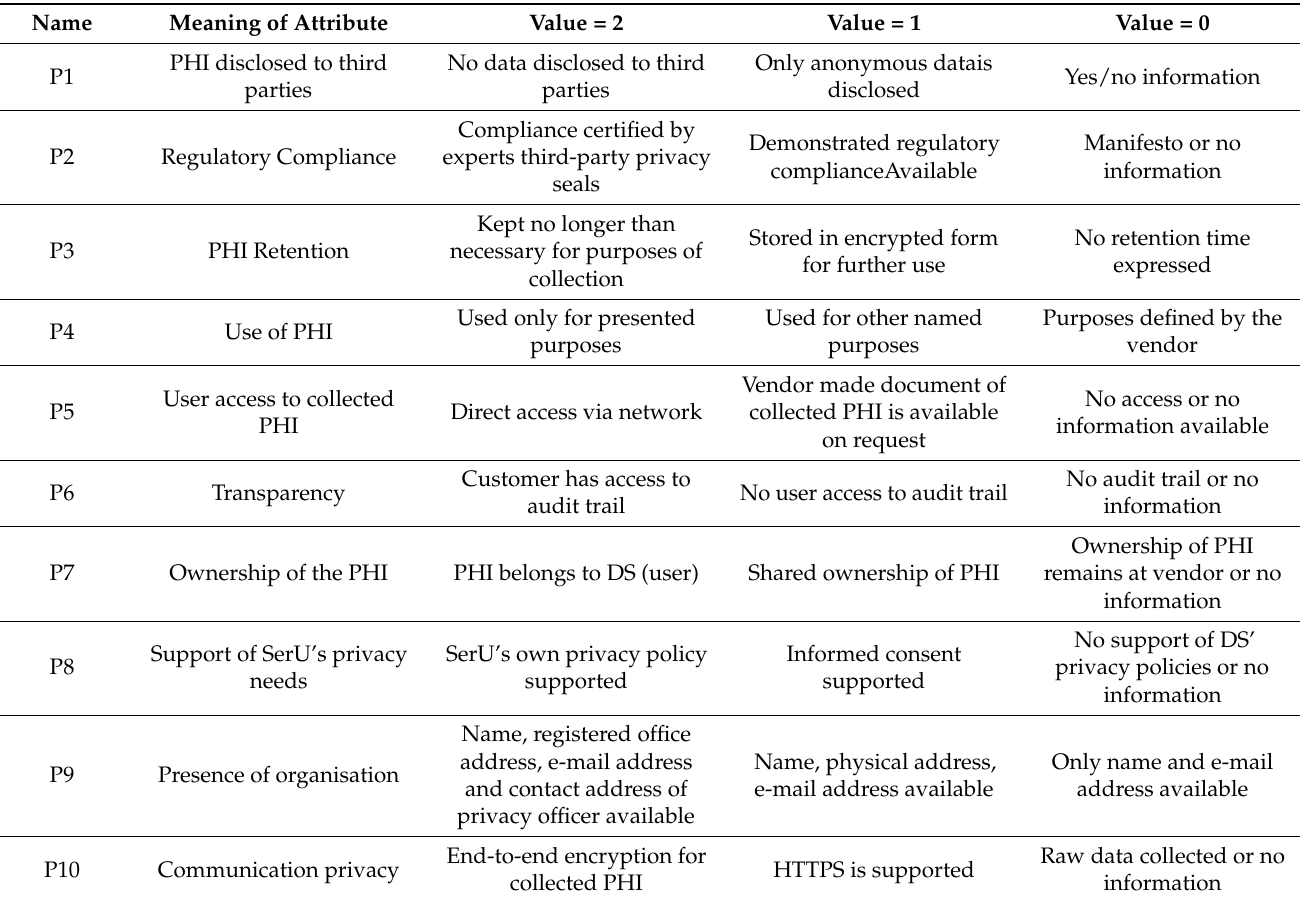
Table 3. Selected privacy attributes and their possible